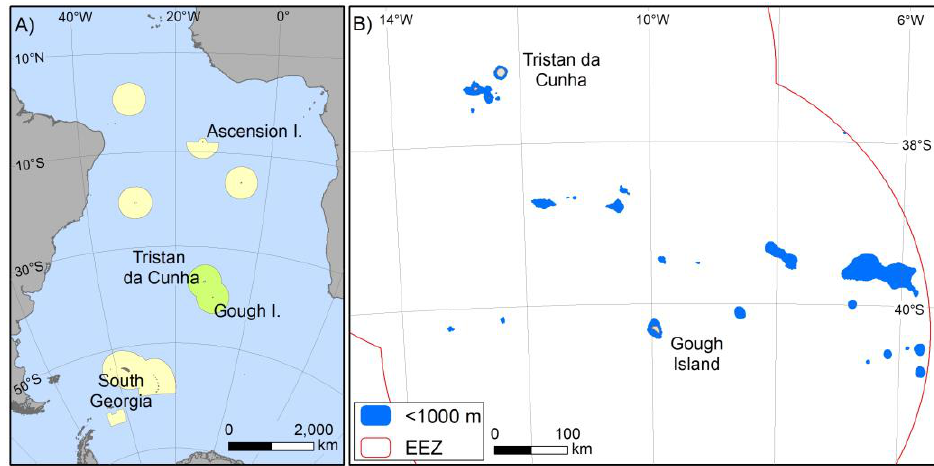
Figure 1. Major Marine Protected Areas in the South Atlantic Ocean ( A ) and detail of Tristan da Cunha’ s MPZ ( B ). The current study focussed on the Tristan da Cunha EEZ (shown in green in panel A), of which 91% is no take, comprising all offshore areas further than 50 nm from the northern Islands and 40 nm from Gough Island, with the exception of some areas of the larger seamounts that remain open to demersal longline fishing. Exclusive Economic Zones (red line) and locations shallower than 100 m depth (blue shade) is shown ( B ). Bathymetric data is GEBCO held by the British Oceanographic Data Centre (The GEBCO_2014 Grid, version 20150318, www.gebco.net, accessed on July